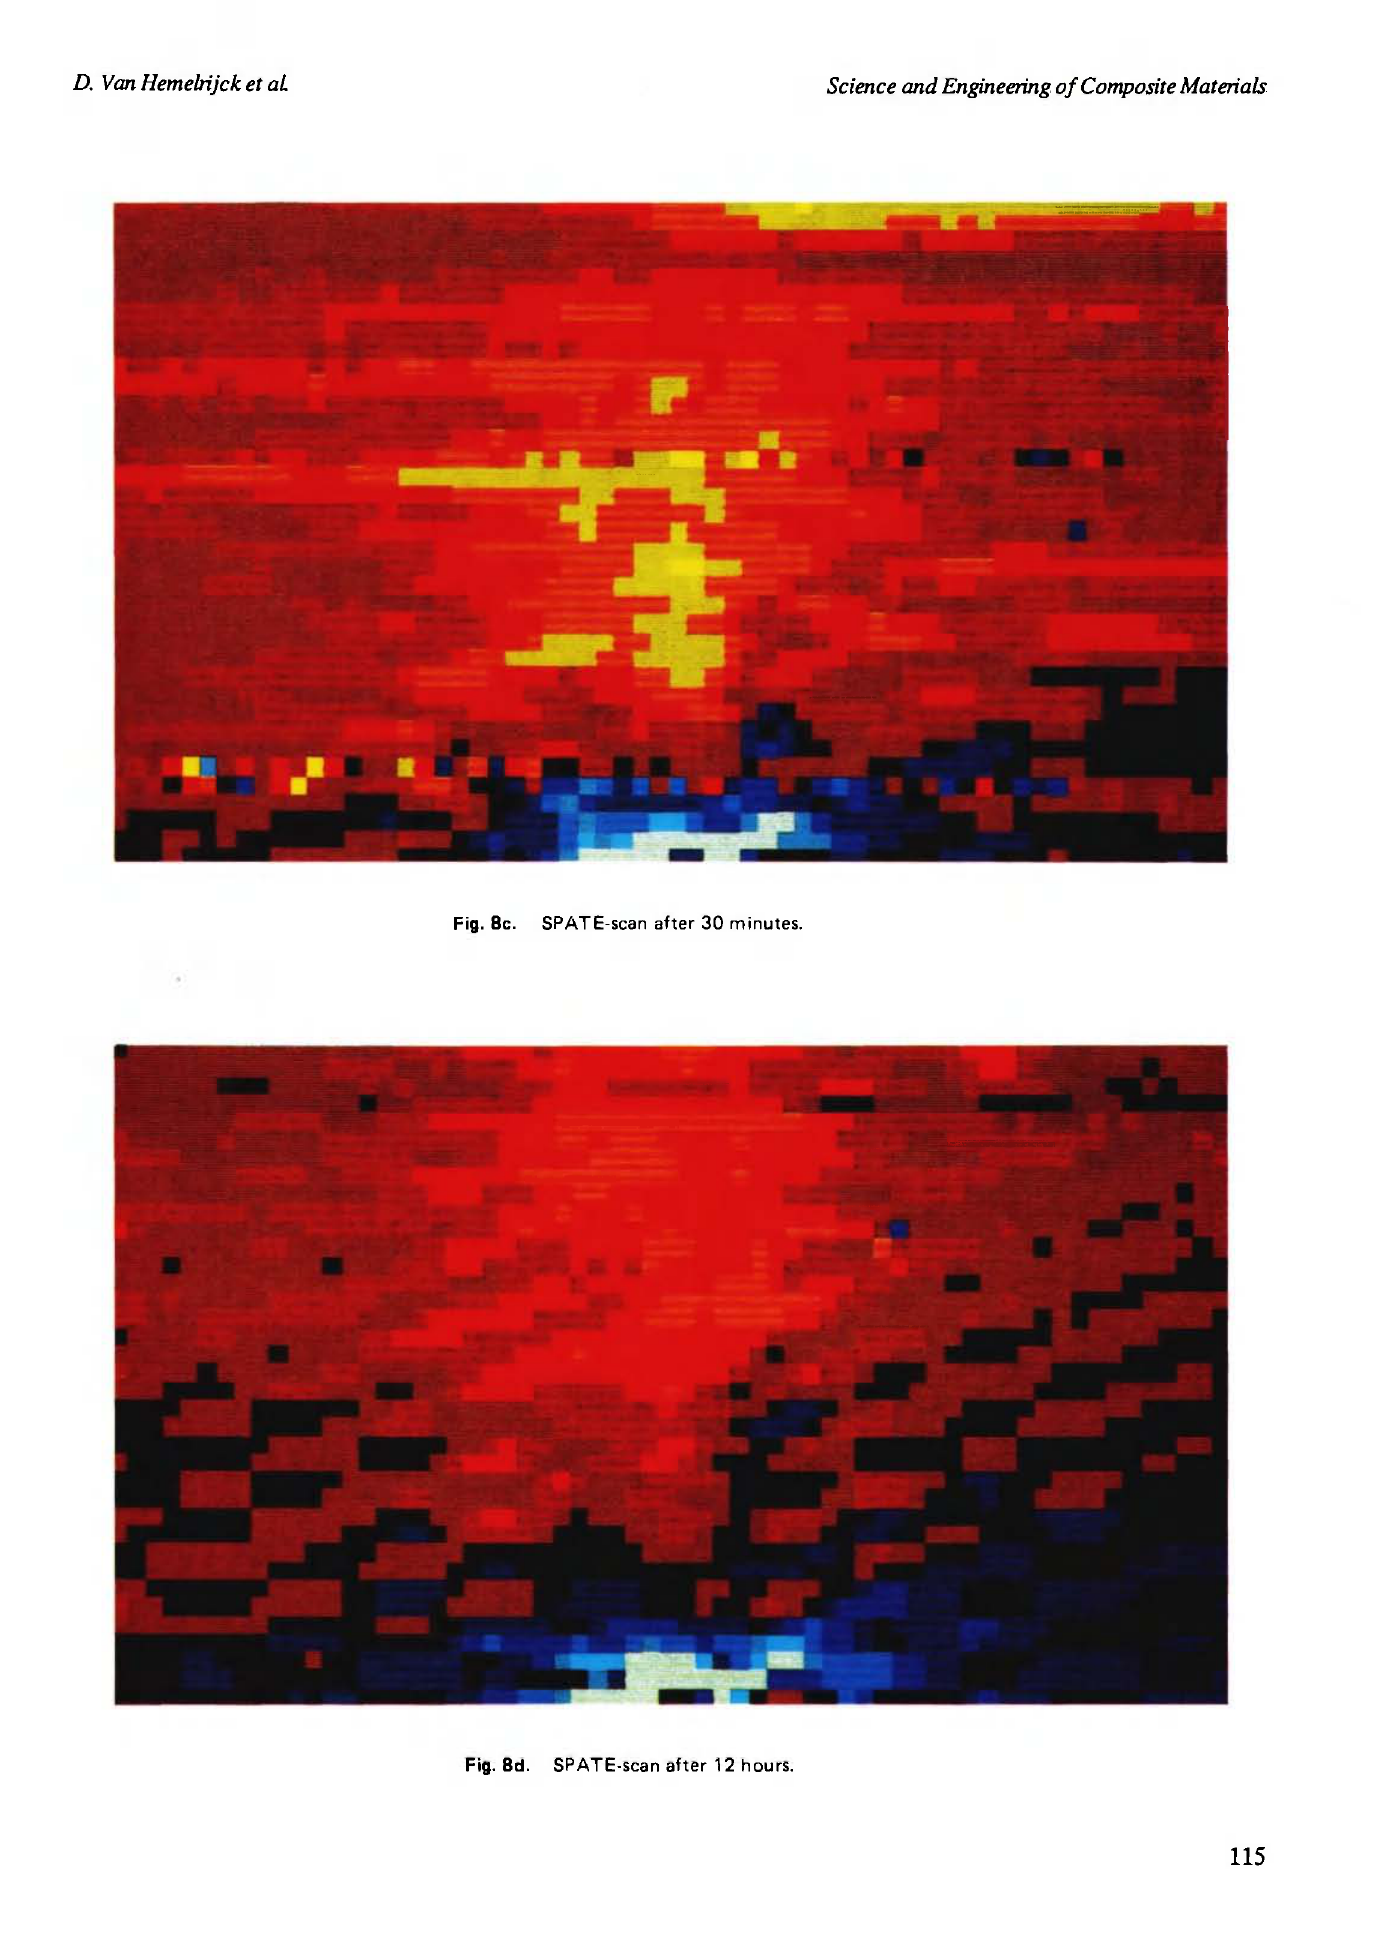
Fig. 8d. SPATE-scan after 12